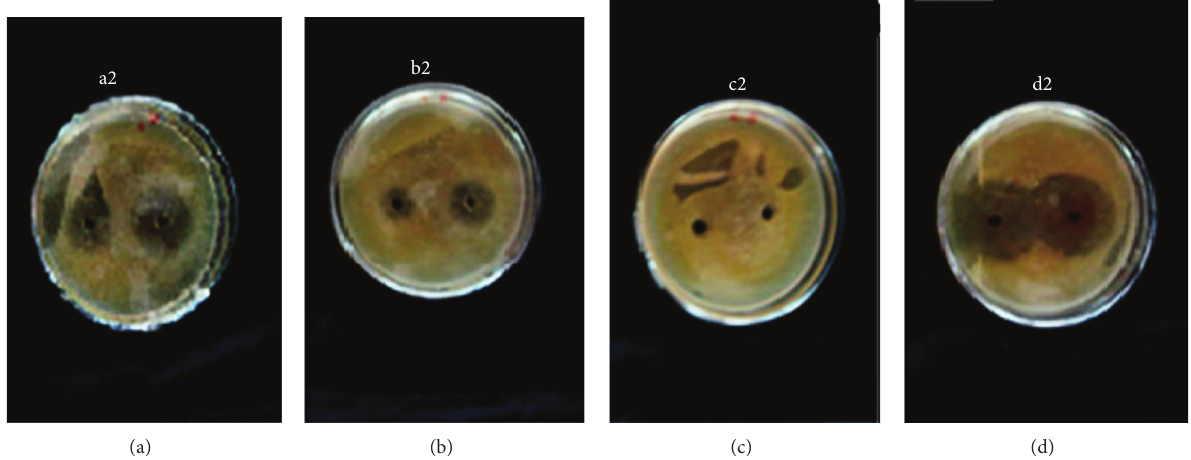
Figure5:Zoneofinhibitionbycoppernanoparticles(jasminebud-shaped)againsthumanpathogens—(a) Escherichiacoli ,(b) Staphylococcus aureus , (c) solvent, (d)